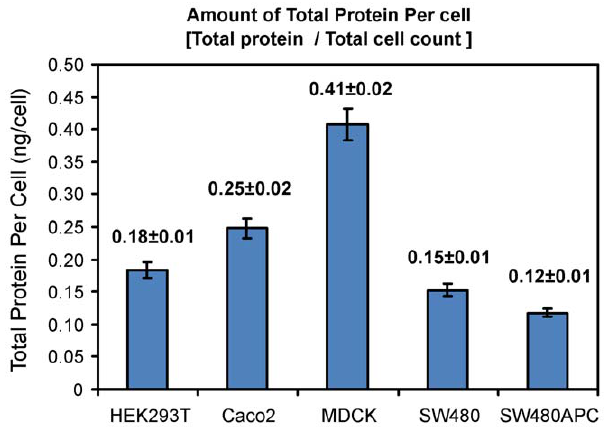
Figure 5. Total protein per cell for each cell line. Error bar: Root Mean Squared Error (SEM).